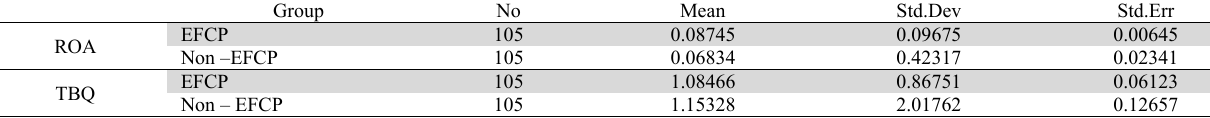
Group financial performance and Bartlett’s test for equal variances